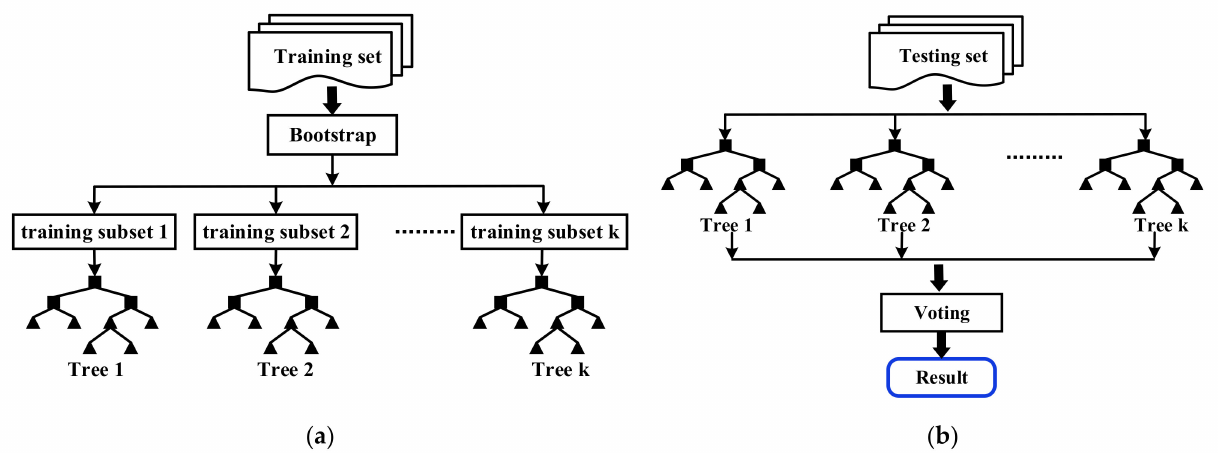
Figure 5. The generation process of random forest. ( a ) The generation of the forest. ( b ) The imple- mentation of